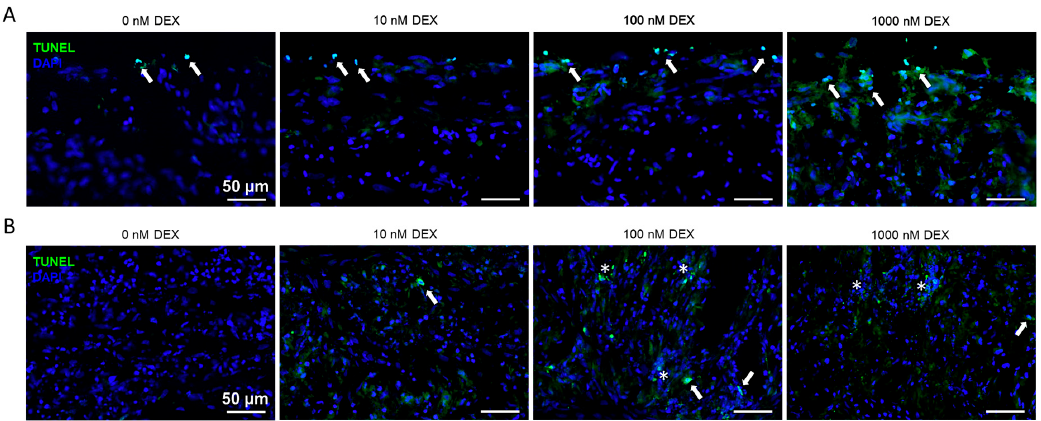
Figure 6. Representative images of TUNEL-stained sections of d1 ( A ) and d14 ( B ) organoids of all groups. Nuclei appear in blue, while TUNEL-positive cells in green. Arrows point still intact TUNEL-labelled nuclei, while asterisks indicate areas of more diffuse TUNEL staining related to nuclear fragmentation.